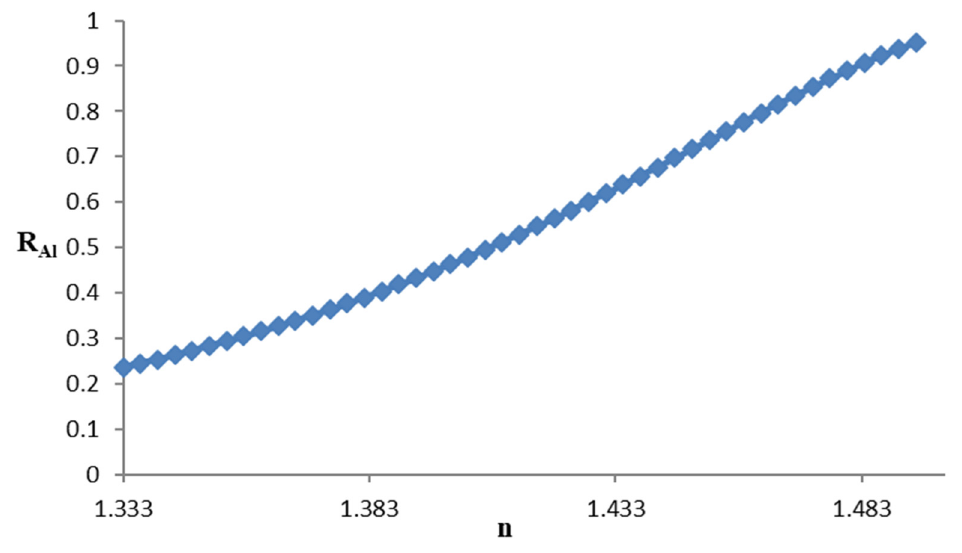
Figure 6. Reflectance curve vs. refractive index of the sucrose solution. The reflectance curves vs. the concentration of sucrose are shown in Figure 7.